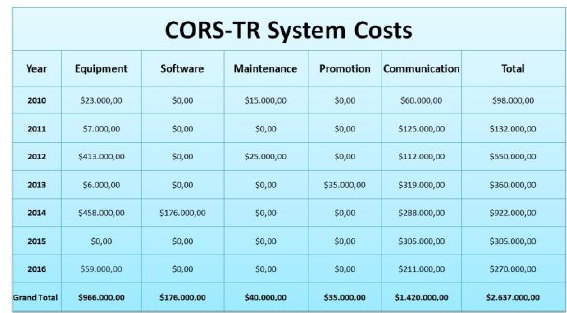
Table 4: CORS-TR System Expenditures between 2010 and